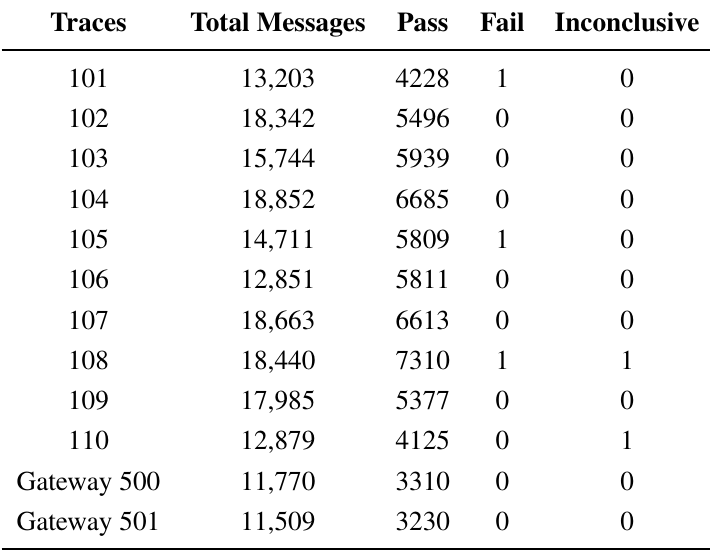
Table 7. Test results for Property 4 (Day